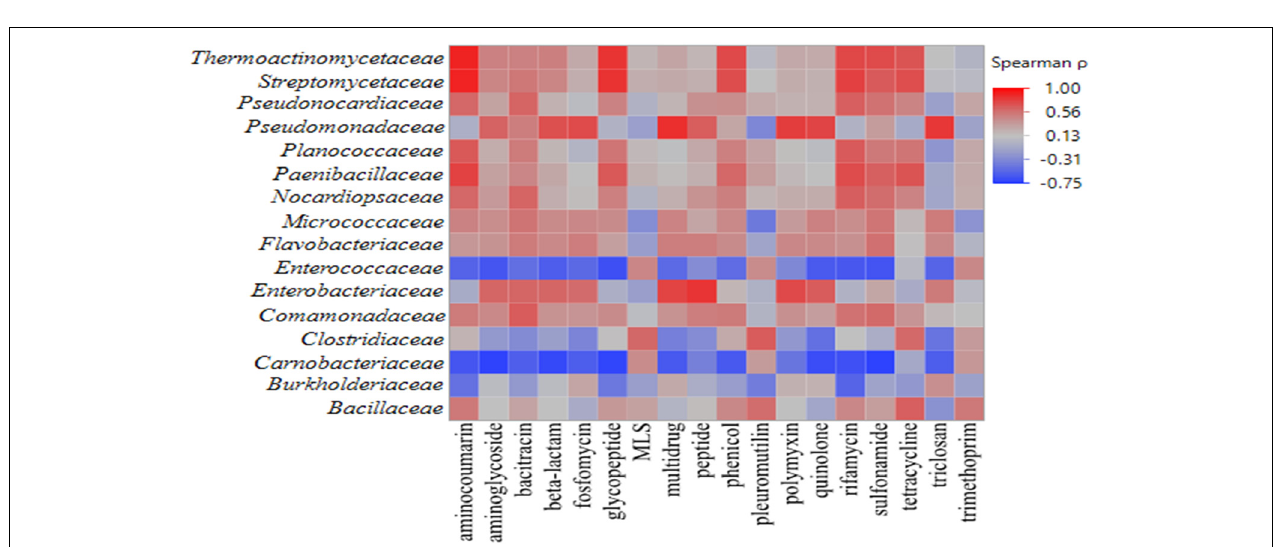
FIGURE 3 | Effect of washing on the survival and regrowth of inoculated antibiotic resistant E. coli O157:H7, Pseudomonas , and aerobic heterotrophic bacteria after 1 and 14 days of storage at 4 ◦ C. Bars represent average log CFU/g and error bars represent standard error from the mean ( n = 3). Connecting letters indicate statistical significance among non-irradiated unwashed and non-irradiated washed samples as well as among days 1 and 14 samples (ANOVA, p < 0.05).